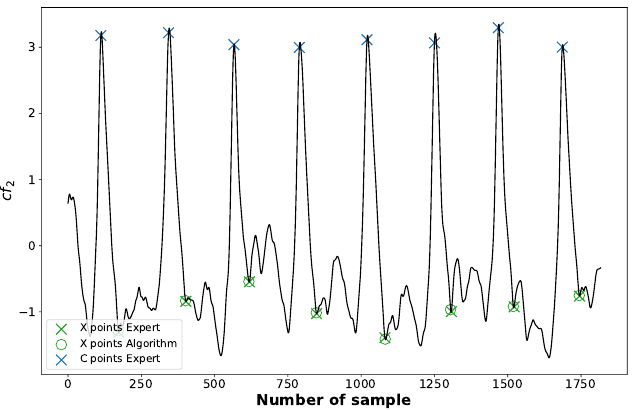
Figure 8. The positions of X points identified by an expert (crosses “ × ”) and those detected by an algorithm (circles “o”).